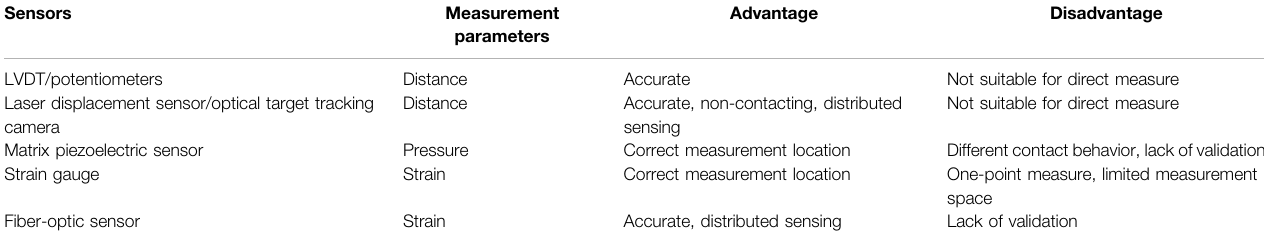
TABLE 4 | Comparation of different methods of curvature measurement.